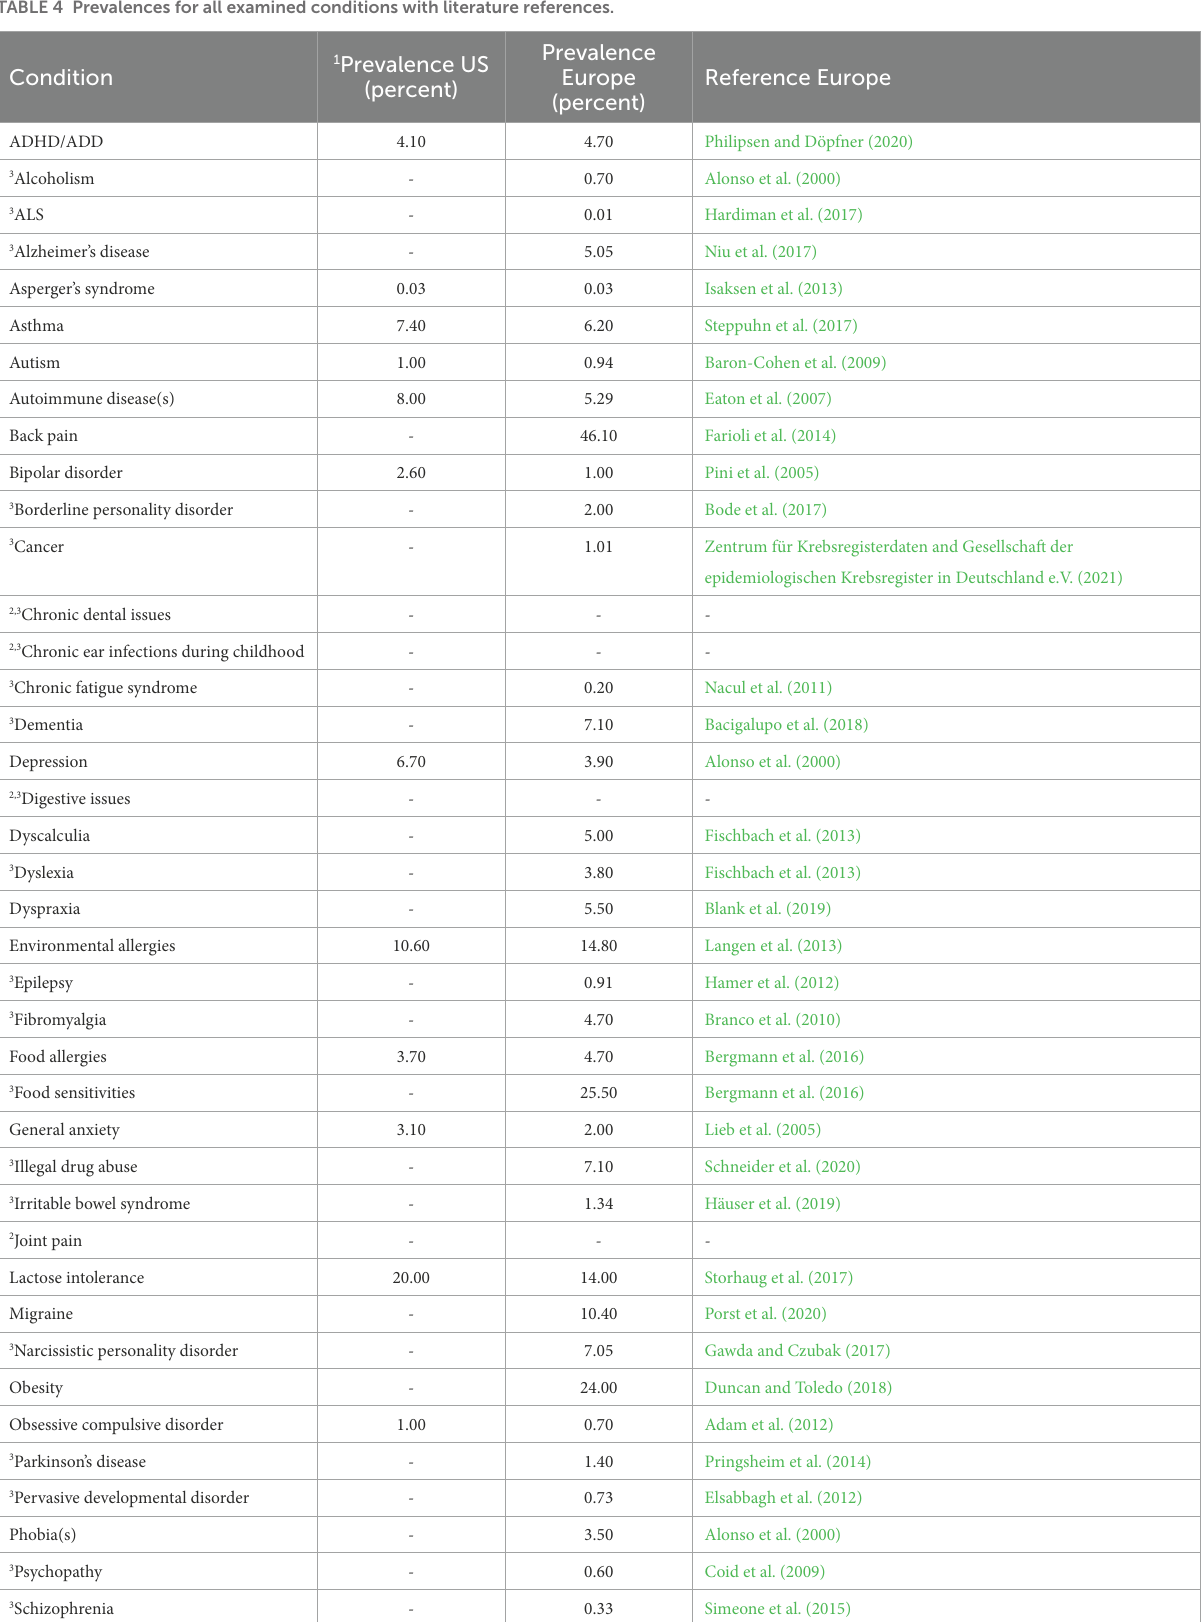
TABLE 4 Prevalences for all examined conditions with literature